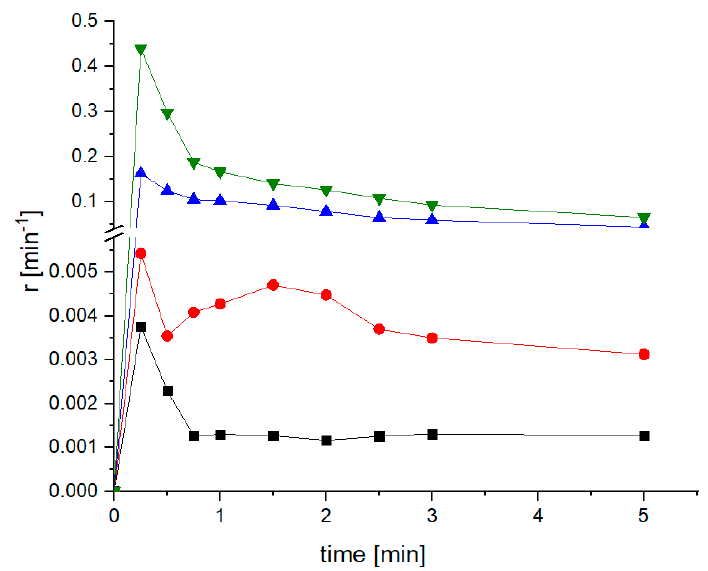
Figure 5. Profiles of the relative release rate of untreated MLX (R0, black) micronized for 10 min (R10-0/10, red); mixed, micronized MLX with 15 wt.% SLS (R10-15/10, blue); and co-milled MLX with 15 wt.% SLS with 10 mm balls for 10 min (CM10-15/10, green).